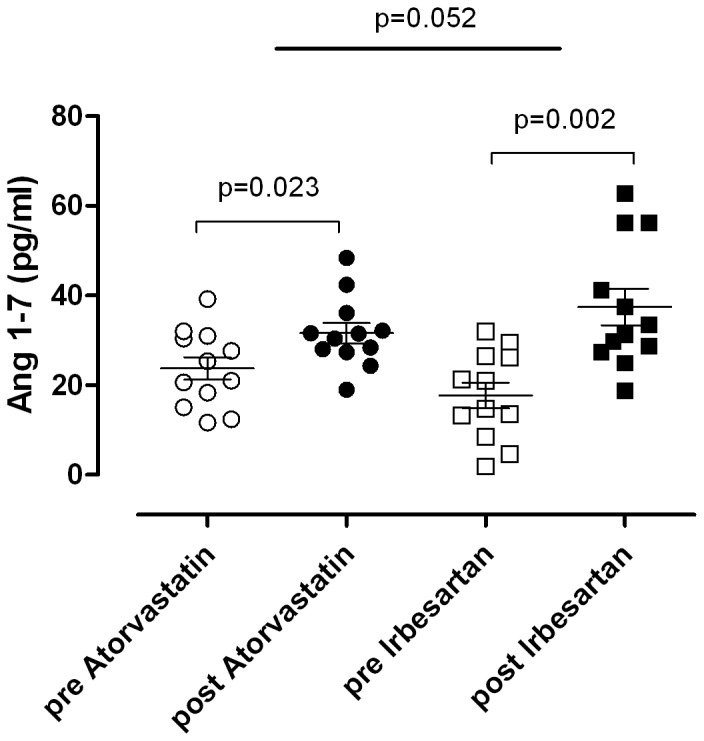
Atorvastatin and irbesartan influences on plasma concentrations of angiotensin-(1–7).Within-group differences were analyzed with Students paired t-test and between-group differences with a two-way ANOVA. Data are expressed as individual values and as mean ± SEM.